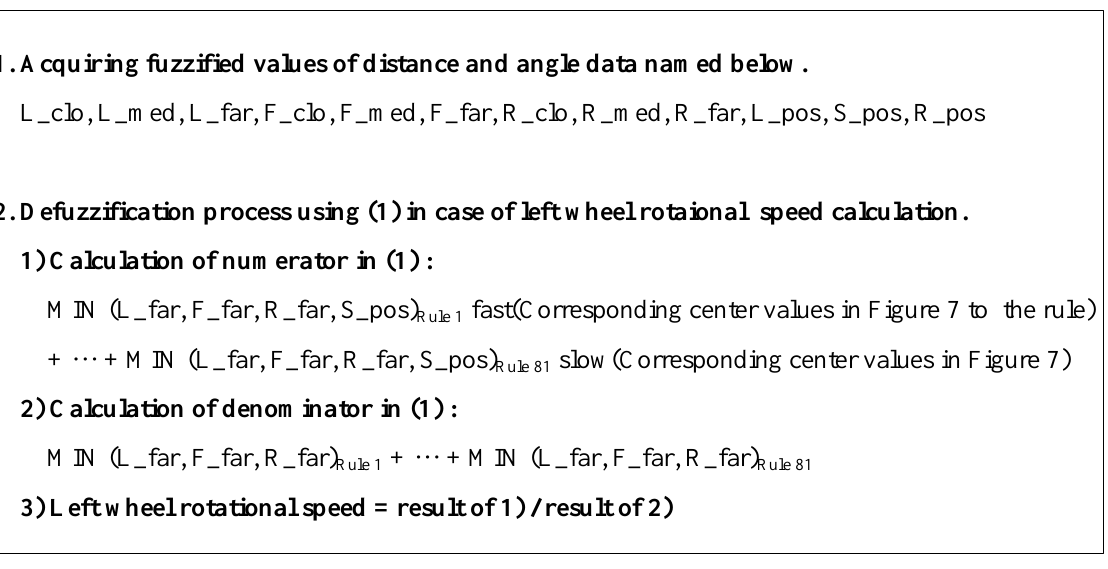
Figure 11. Rule evaluation and defuzzification algorithm.